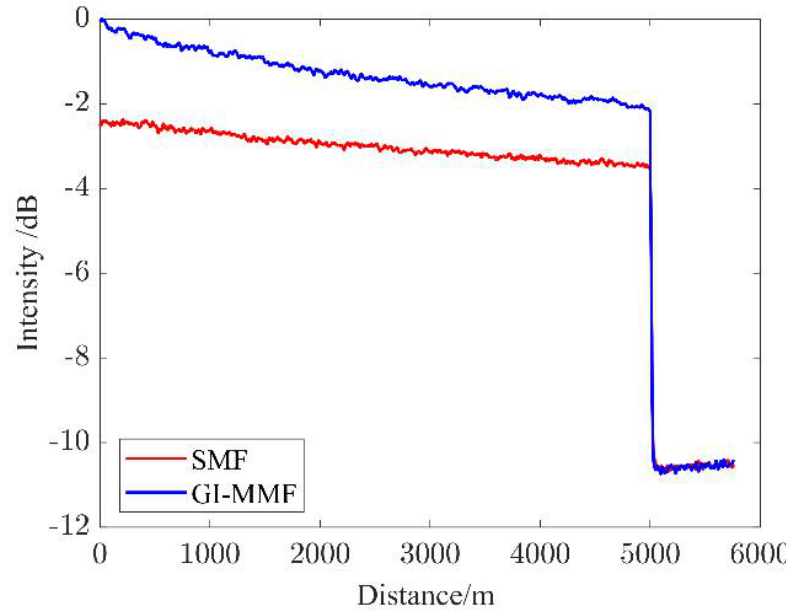
Figure 6. Trace of the measured Brillouin intensity.